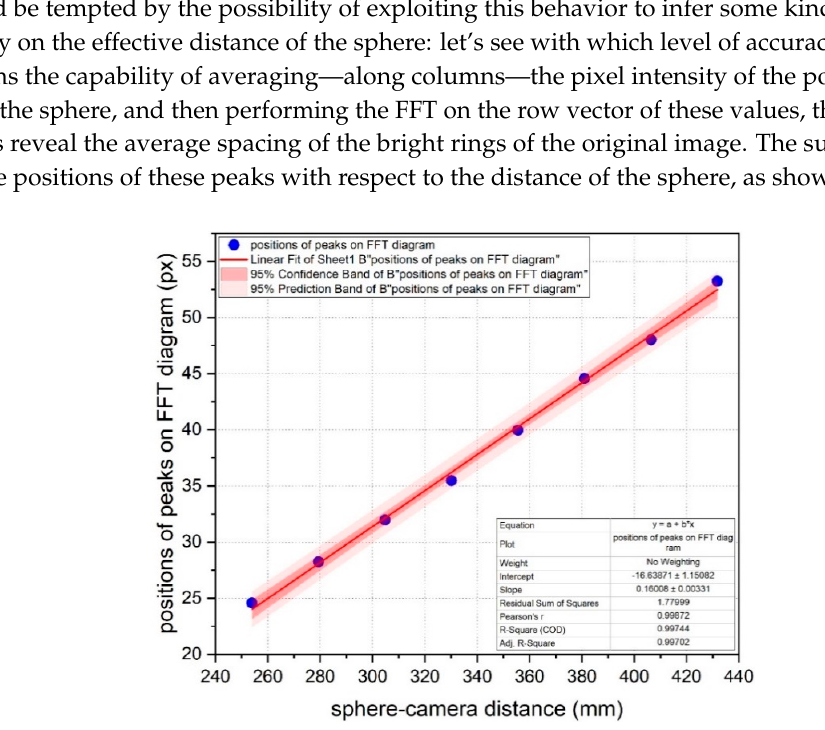
Figure 25. ∆ (cid:3045) for variance ( a ) and FFT-based ( b ) algorithms.